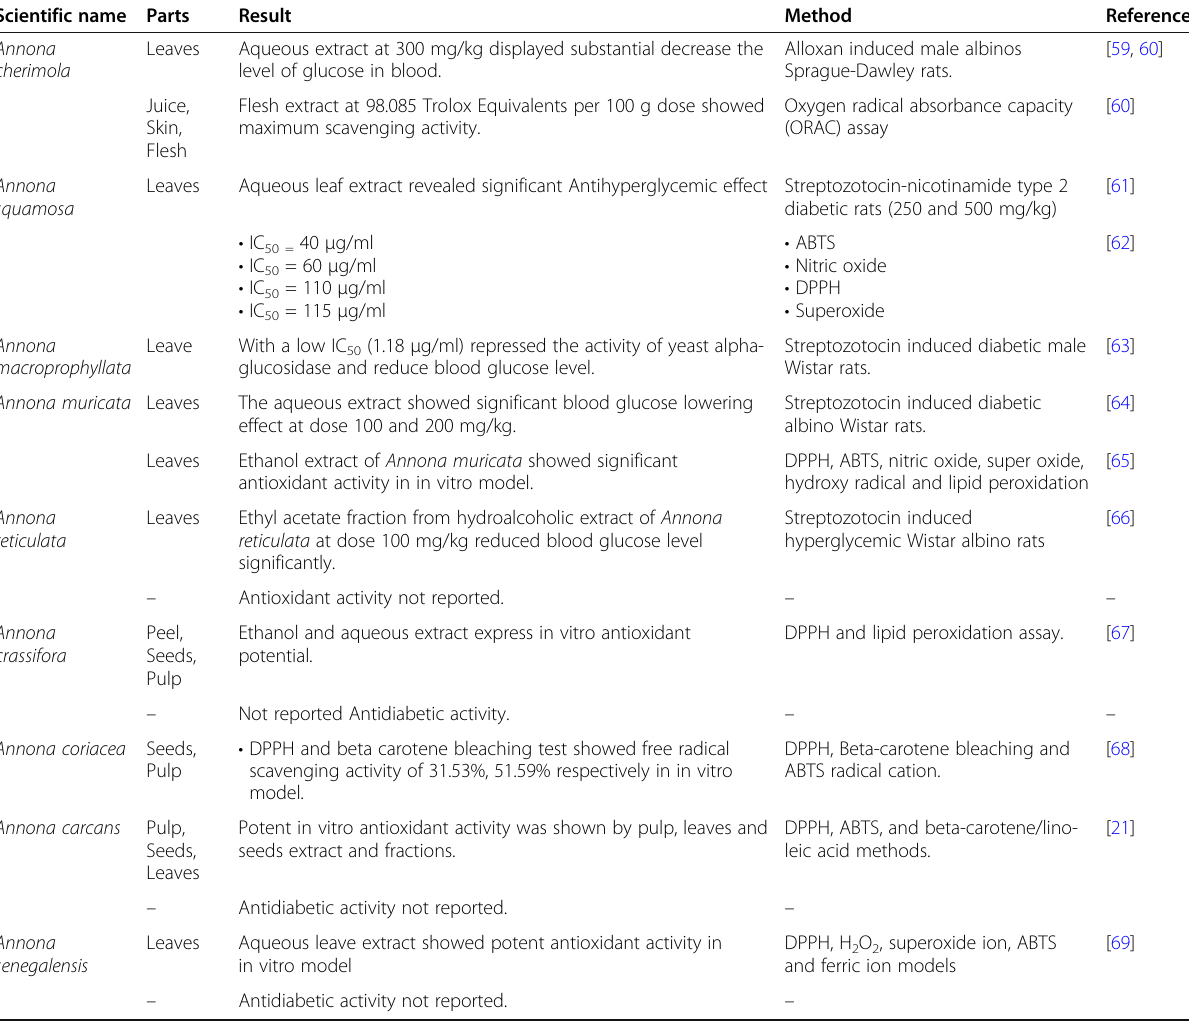
Table 3 Result and methods of antidiabetic and antioxidant